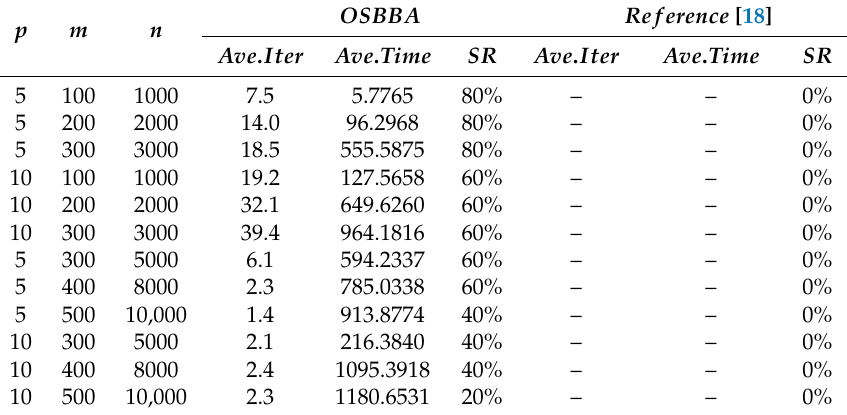
Table 3. The results of random calculations for Example 12.